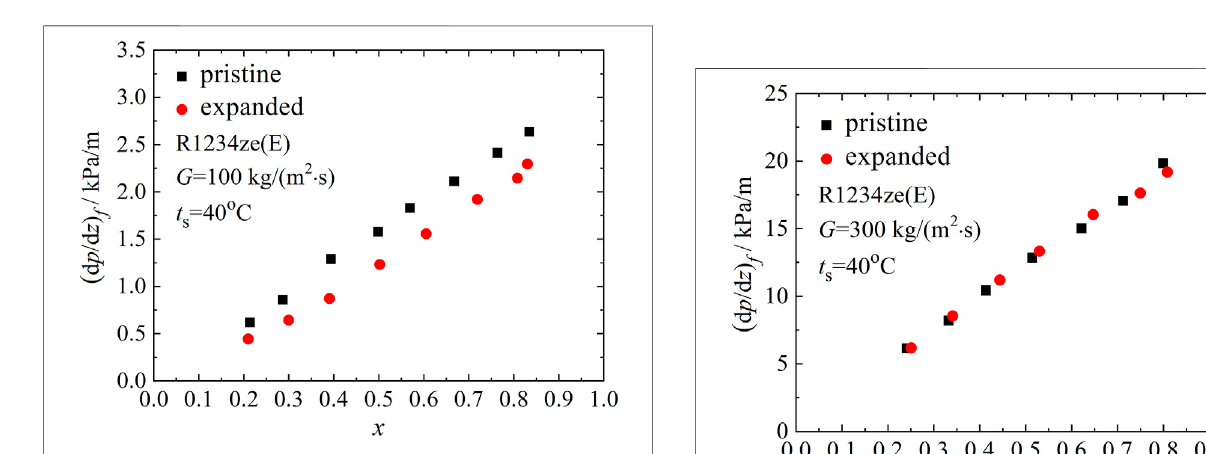
FIGURE 9 | Effect of tube expansion on friction pressure gradients at 100 kg/(m 2 · s).